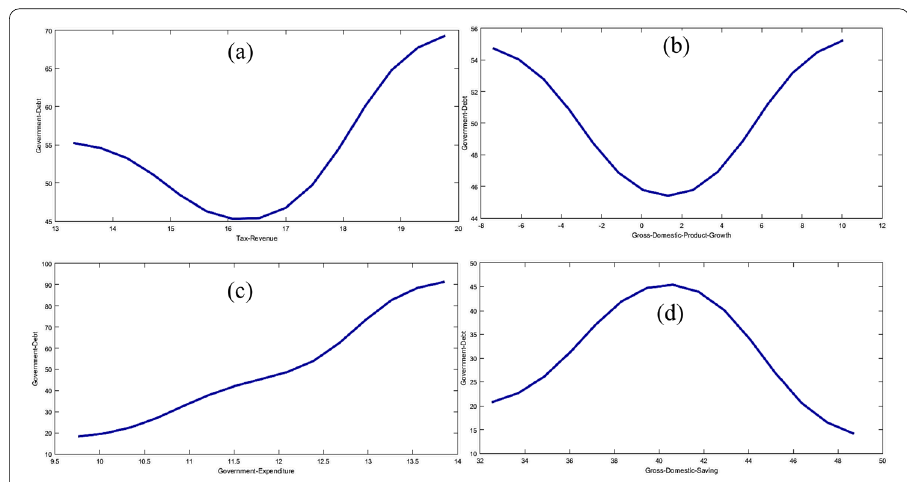
Fig. 6 Two-dimensional surface diagram of input and output parameters after ANFIS analysis. a Individual analysis of tax revenue and external debt; b individual analysis of the gross domestic product and external debt; c individual analysis of government expenditure and external debt; d individual analysis of gross domestic saving and external